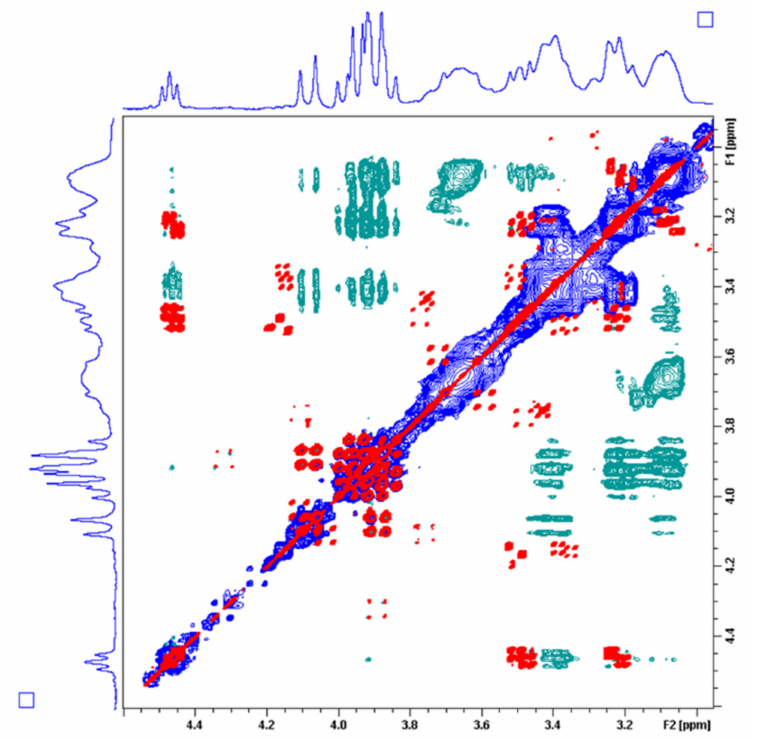
Figure 6. Overlap of the 1 H 2D COSY (red) and NOESY spectra of Y(DO3A-ACE) − in D 2 O at 80 ◦ C. NOESY blue cross peaks are in the same phase of the diagonal and green are in the opposite phase.